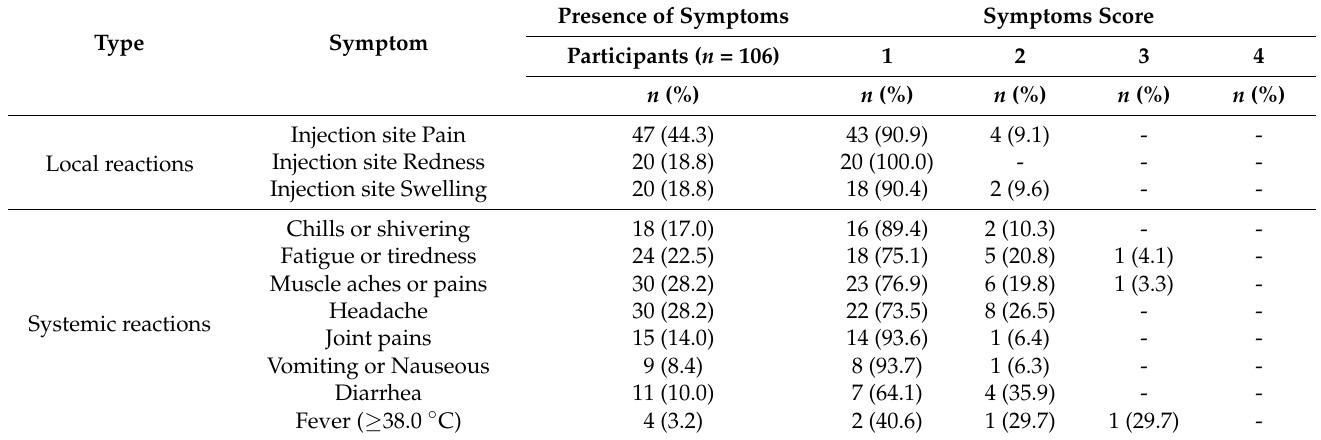
Table 2. Symptoms experienced after the first vaccination with BNT162b2 (Pfizer/ BioNTech) vaccine (Conmirnaty ® ).